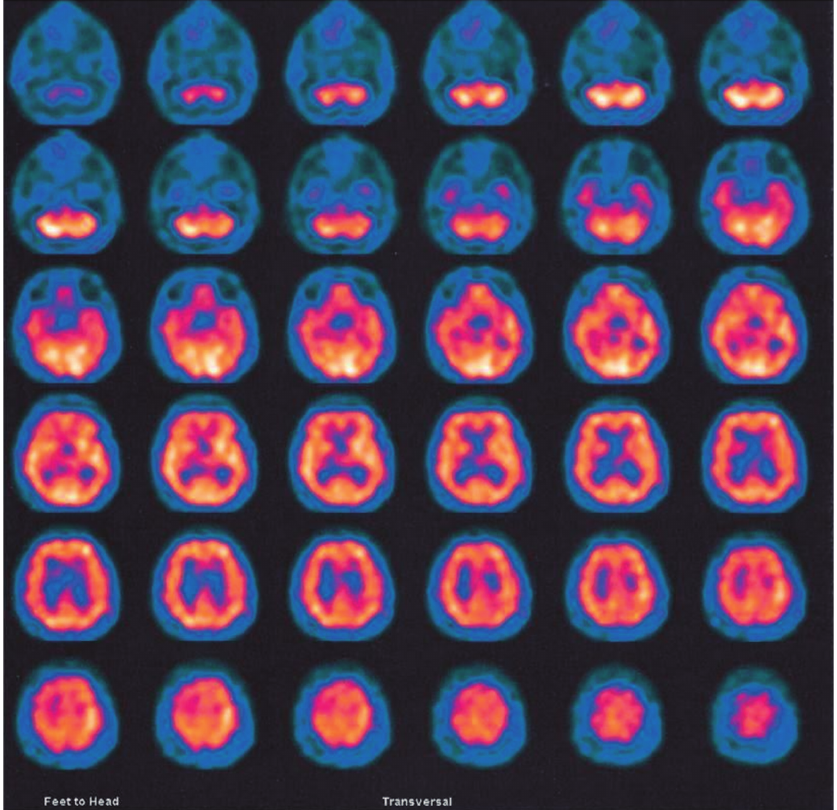
Figure 1. DAT SPECT imaging showing reduced radiotracer uptake in the basal